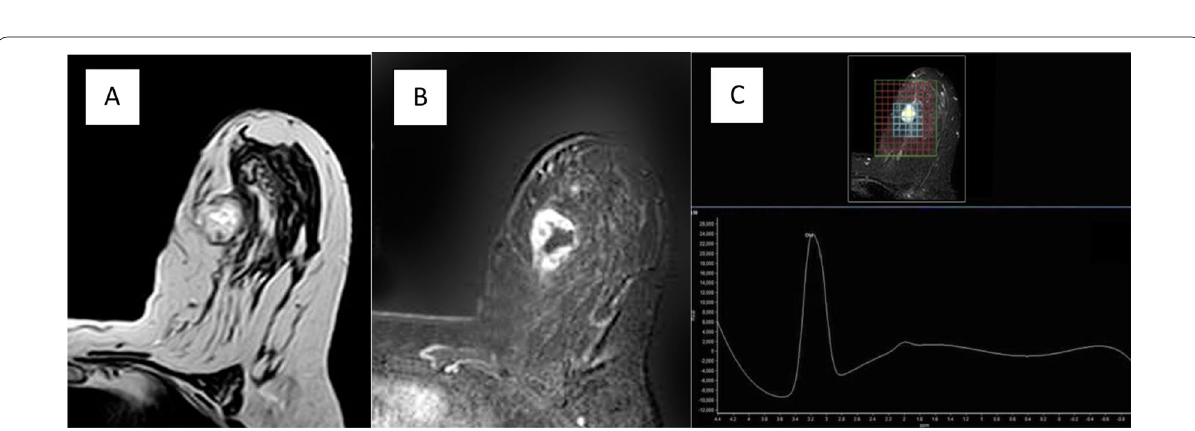
Fig. 4 A 49-year-old female with a left breast mucinous carcinoma. A Axial T2-WI showing a partially circumscribed lesion of mixed high signal. B Axial postcontrast T1-WI with subtraction, showing heterogeneous enhancement. C MRS study showing a positive choline